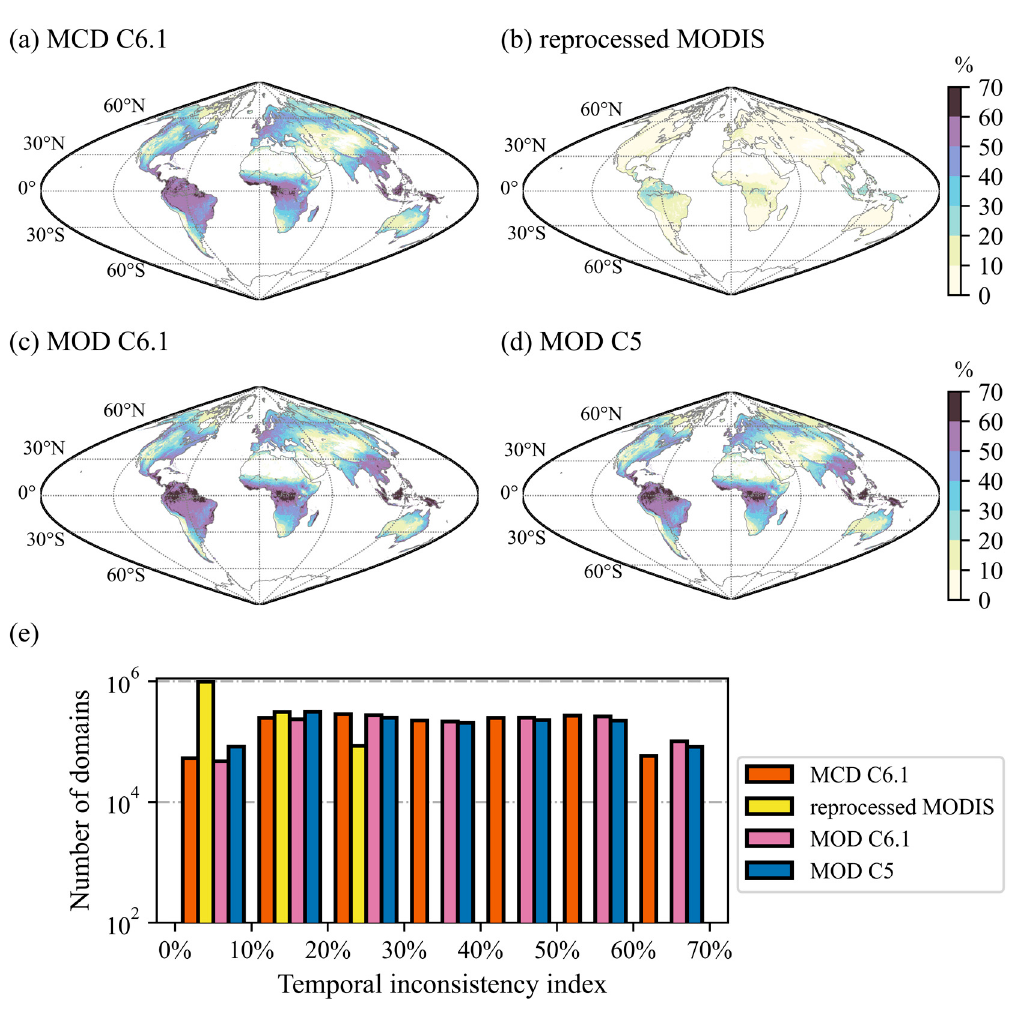
Figure 7. The same as Figure 6 but for temporal inconsistency index